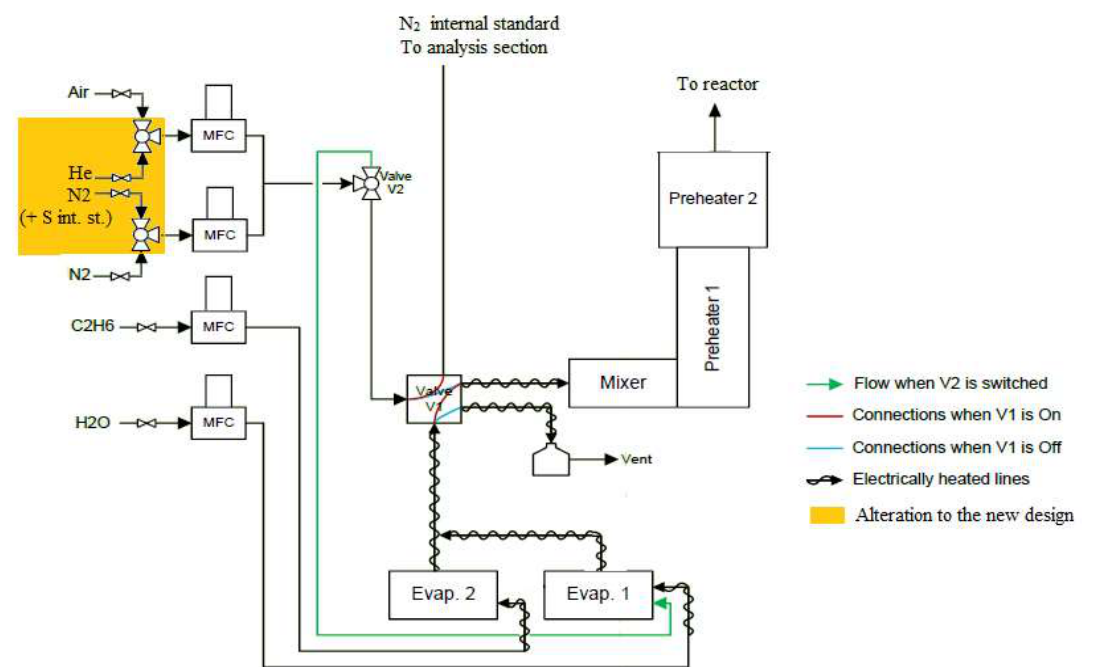
Figure 1. Illustration of the JSR reactor.